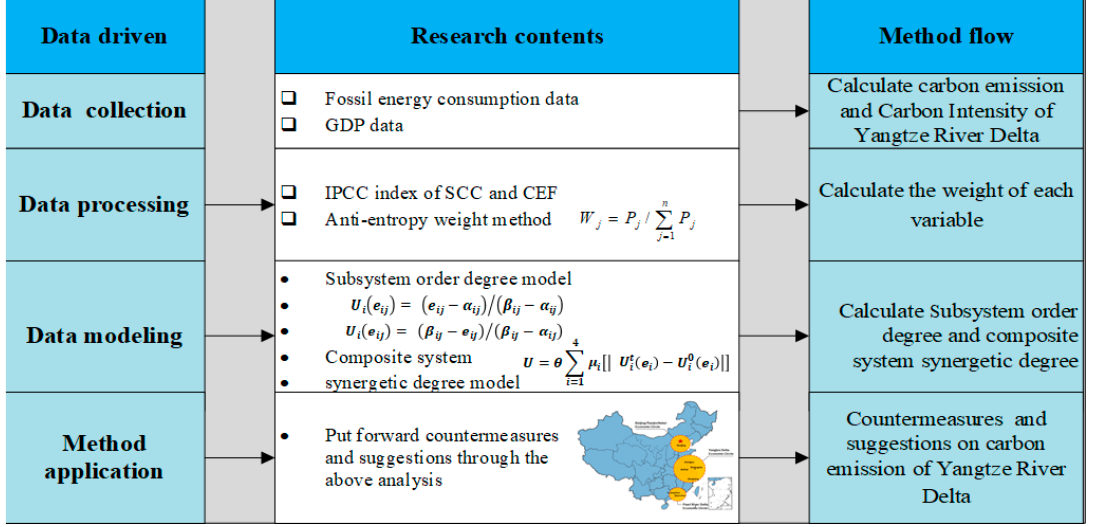
Figure 1. Method flow.